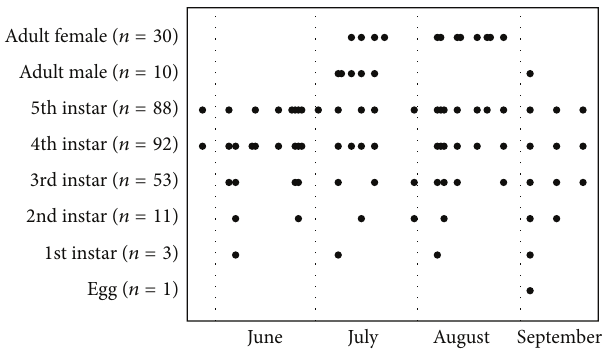
Figure 3: Distribution of life history stages of 288 specimens of C. meridionalis collected at Headquarters Lake from May 28 through September 20,